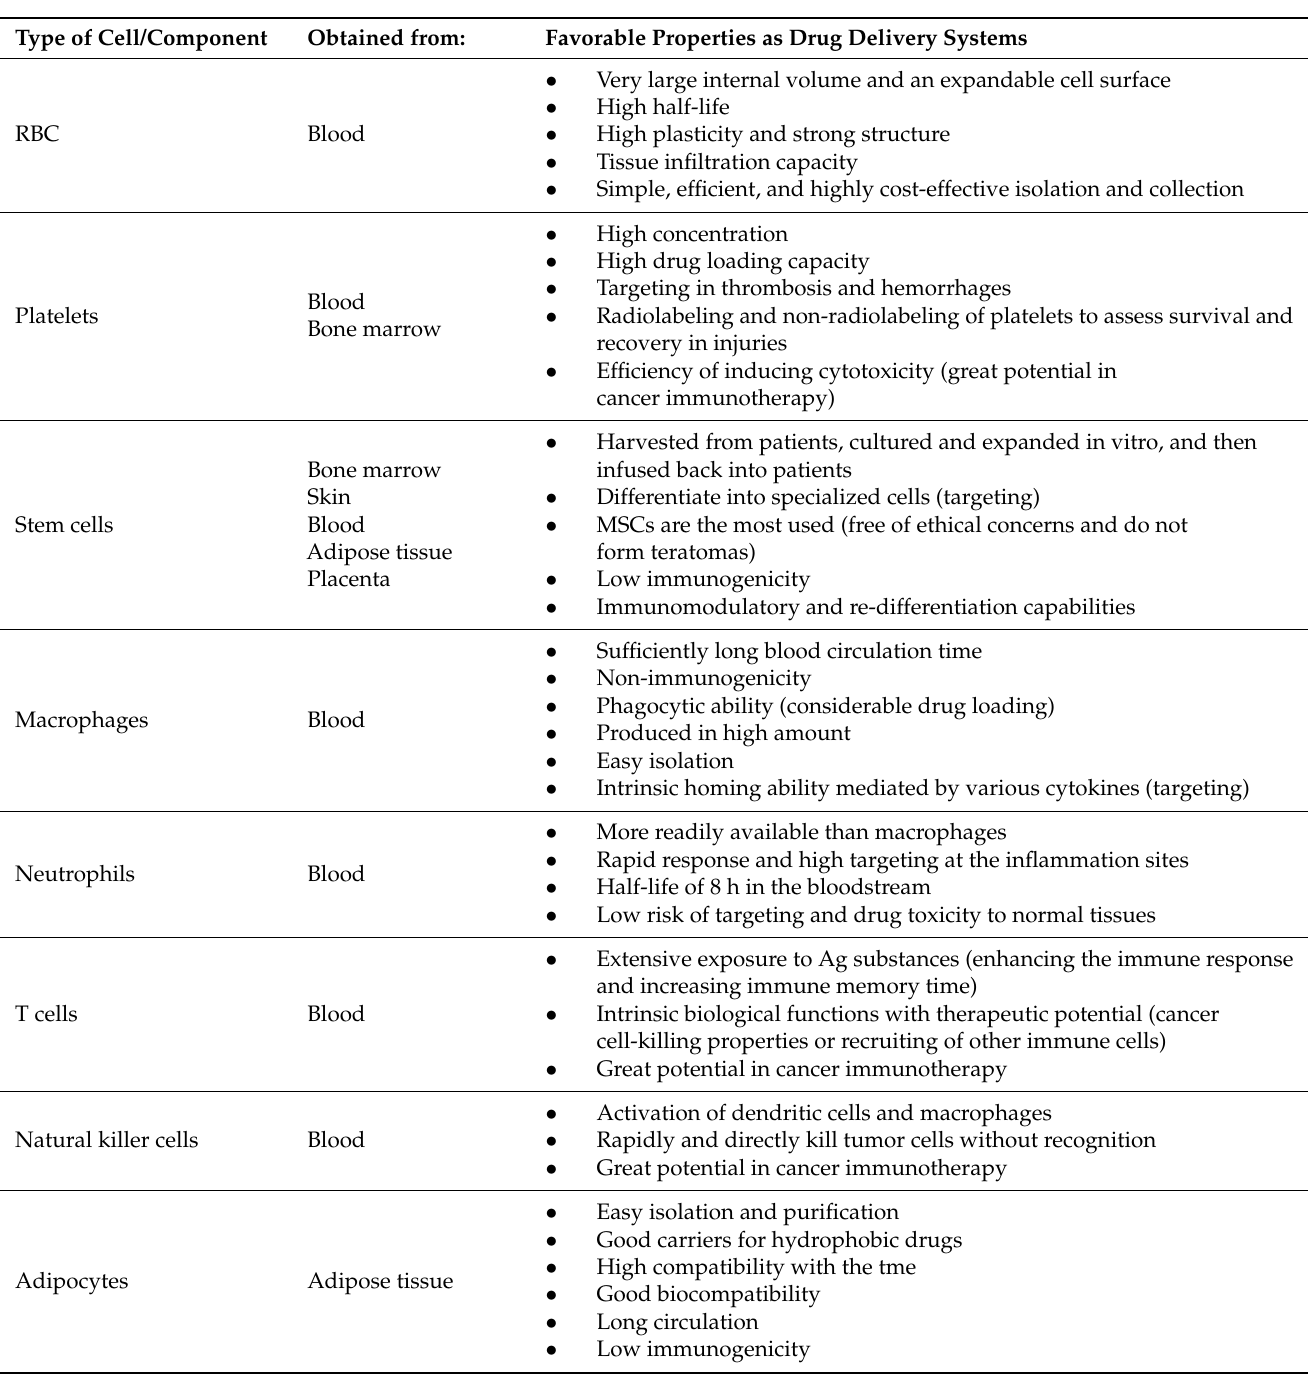
Table 1. Biological-origin drug delivery systems